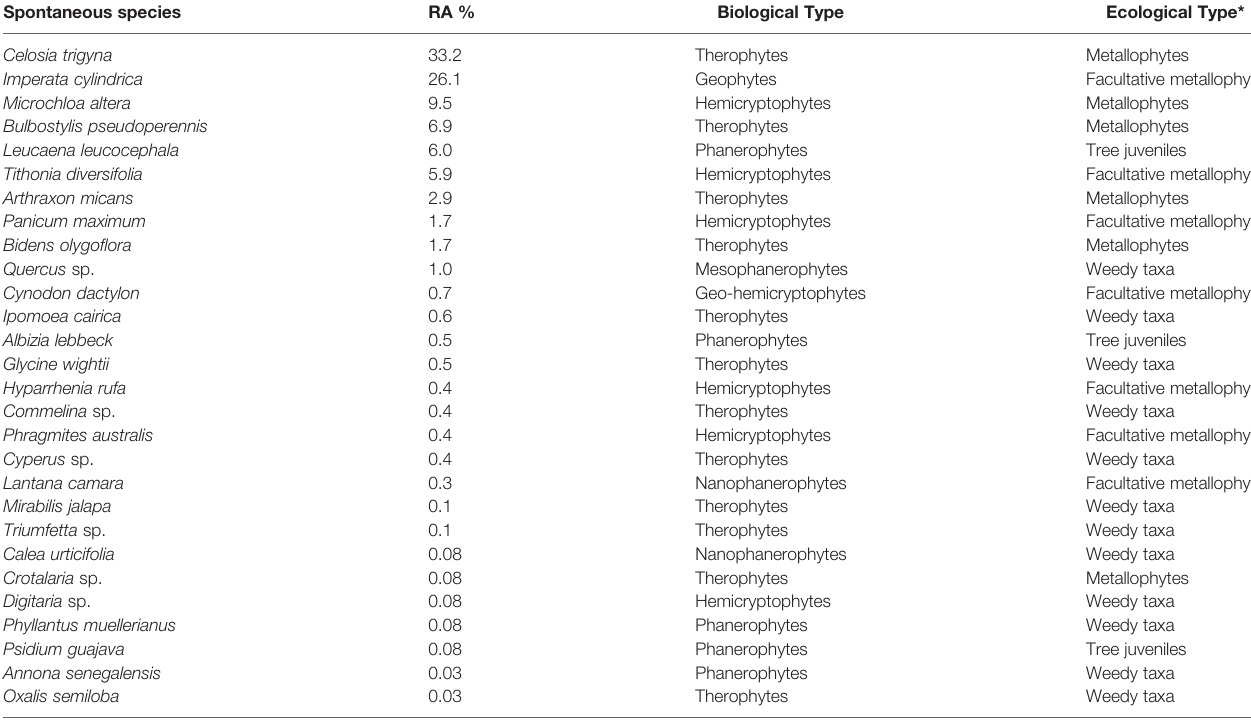
TABLE 4 | Spontaneous vegetation in tree corridors (34 quadrats of 12-m 2 17 corridors in the plantation of 15,000 m 2 ; RA, relative abundance). Spontaneous species